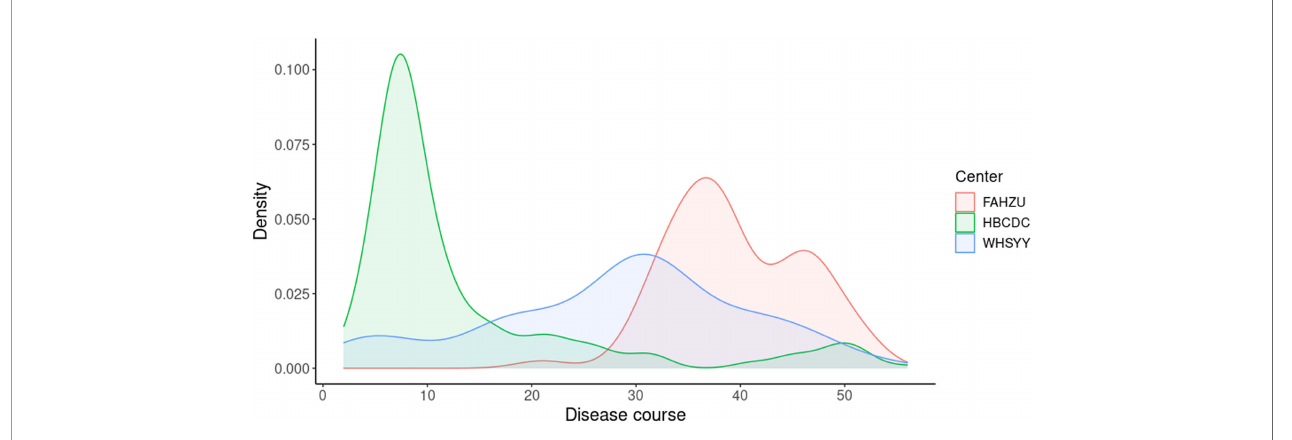
FIGURE 5 | Distribution of disease course in